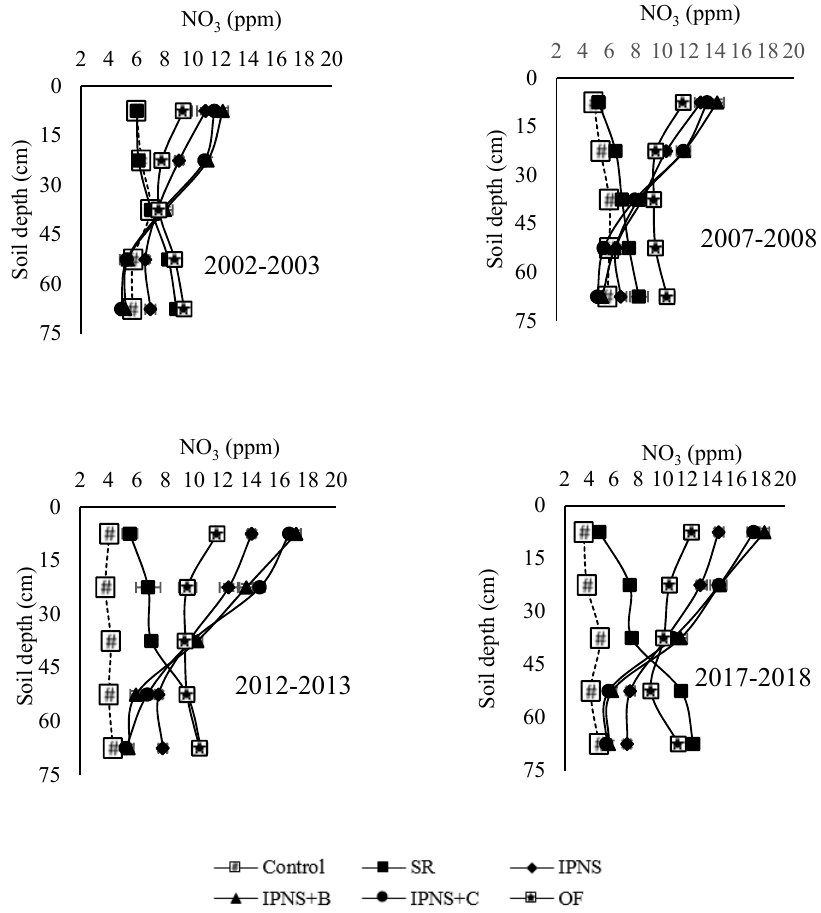
Figure 4. Effects of the nutrient management options on the distribution of nitrate–N in different soil profiles after wheat harvest at five-year intervals of the RWS cycle. Bars indicate the standard error of the mean, n = 4.